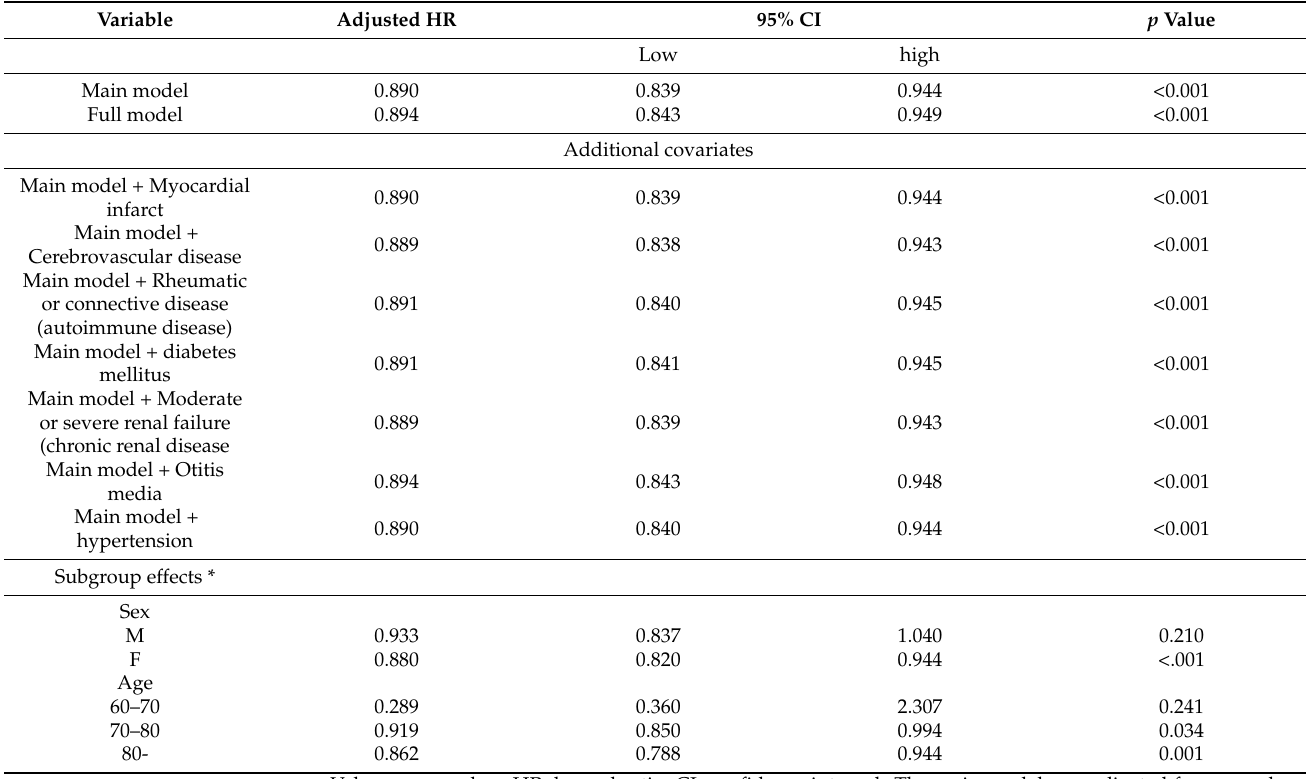
Table 4. Risk of SSNHL compared by multivariable Cox regression